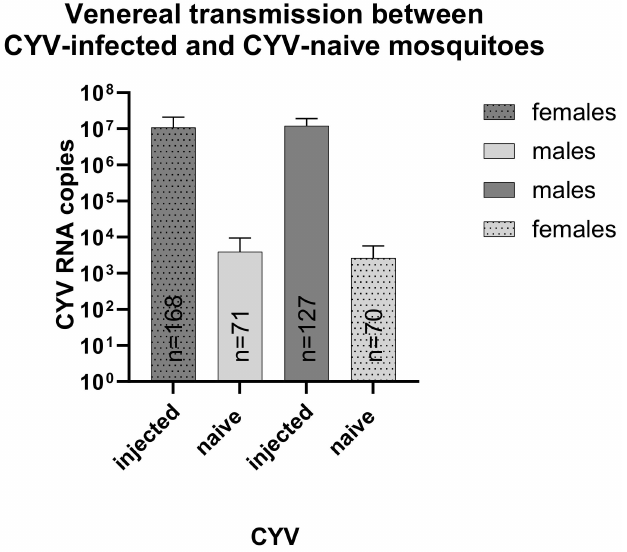
Figure 2. CYV measurement of previously CYV-naïve Cx. pipiens biotype molestus mosquitoes after mating with CYV-positive mating partners. Shown are mean viral RNA copies measured by qRT-PCR calculated for one mosquito (per pool) seven days post-mating, displayed with SD. Dark grey with dots: CYV-injected females (n = 168); dark grey—CYV-injected males (n = 127); light grey with dots: CYV-naïve females (n = 70); light grey—CYV-naïve males (n =